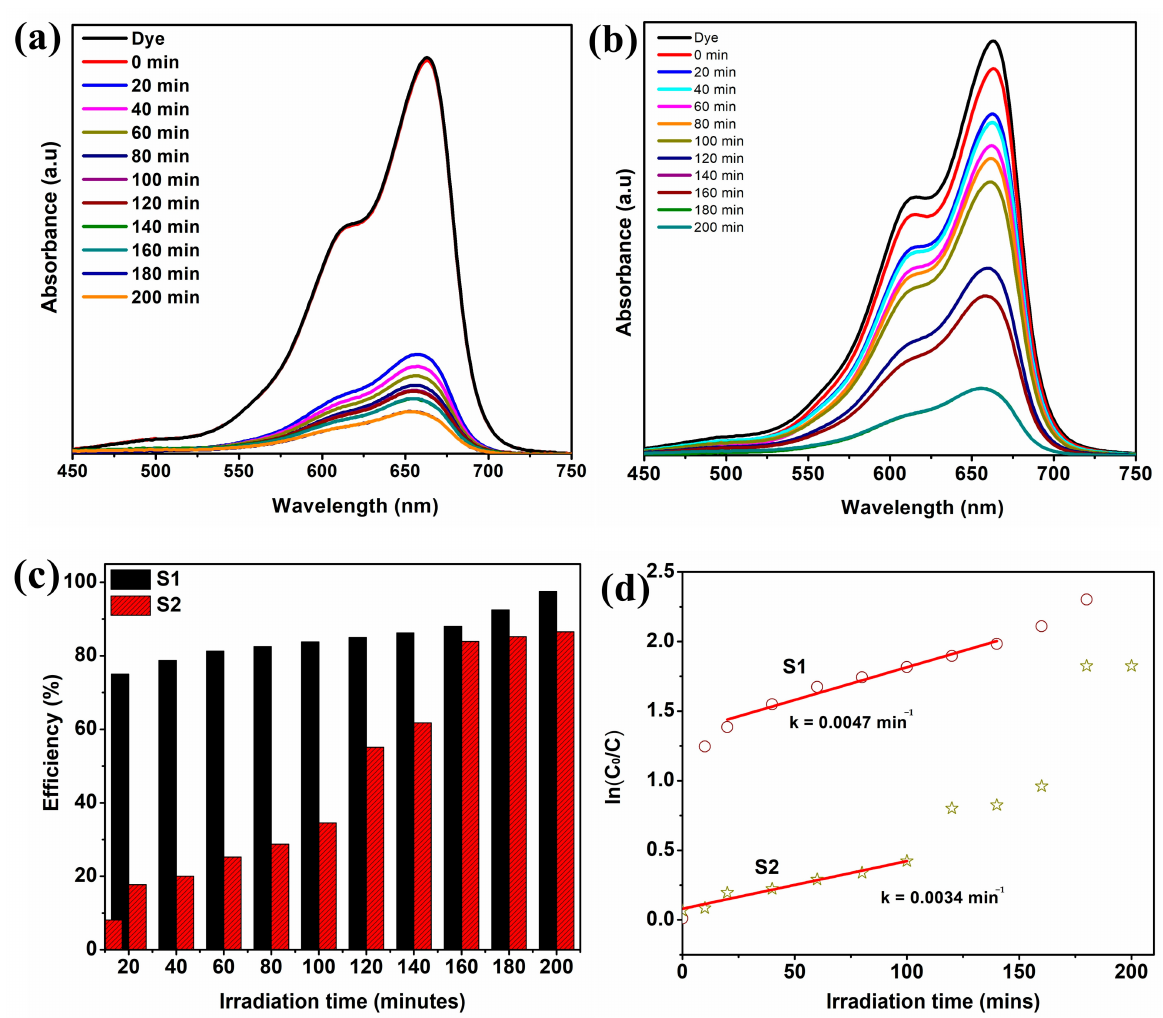
Figure 8. ( a , b ) The time-dependent UV-Visible absorption spectra of MB dye solution in the presence of ZnO/graphene, ( c ) Degradation efficiency of ZnO/graphene as a function of irradiation time, and ( d ) Pseudo-first-order kinetic plot ln(C/C 0 ) versus irradiation